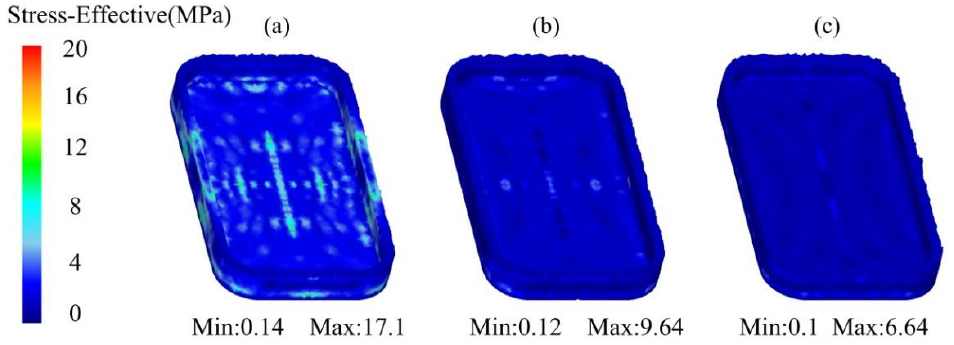
Figure 12. Equivalent stress distribution of the mobile phone shell processed by the thixotropic extrusion at the extrusion speed of ( a ) 5 mm/s, ( b ) 10 mm/s, and ( c ) 15 mm/s.